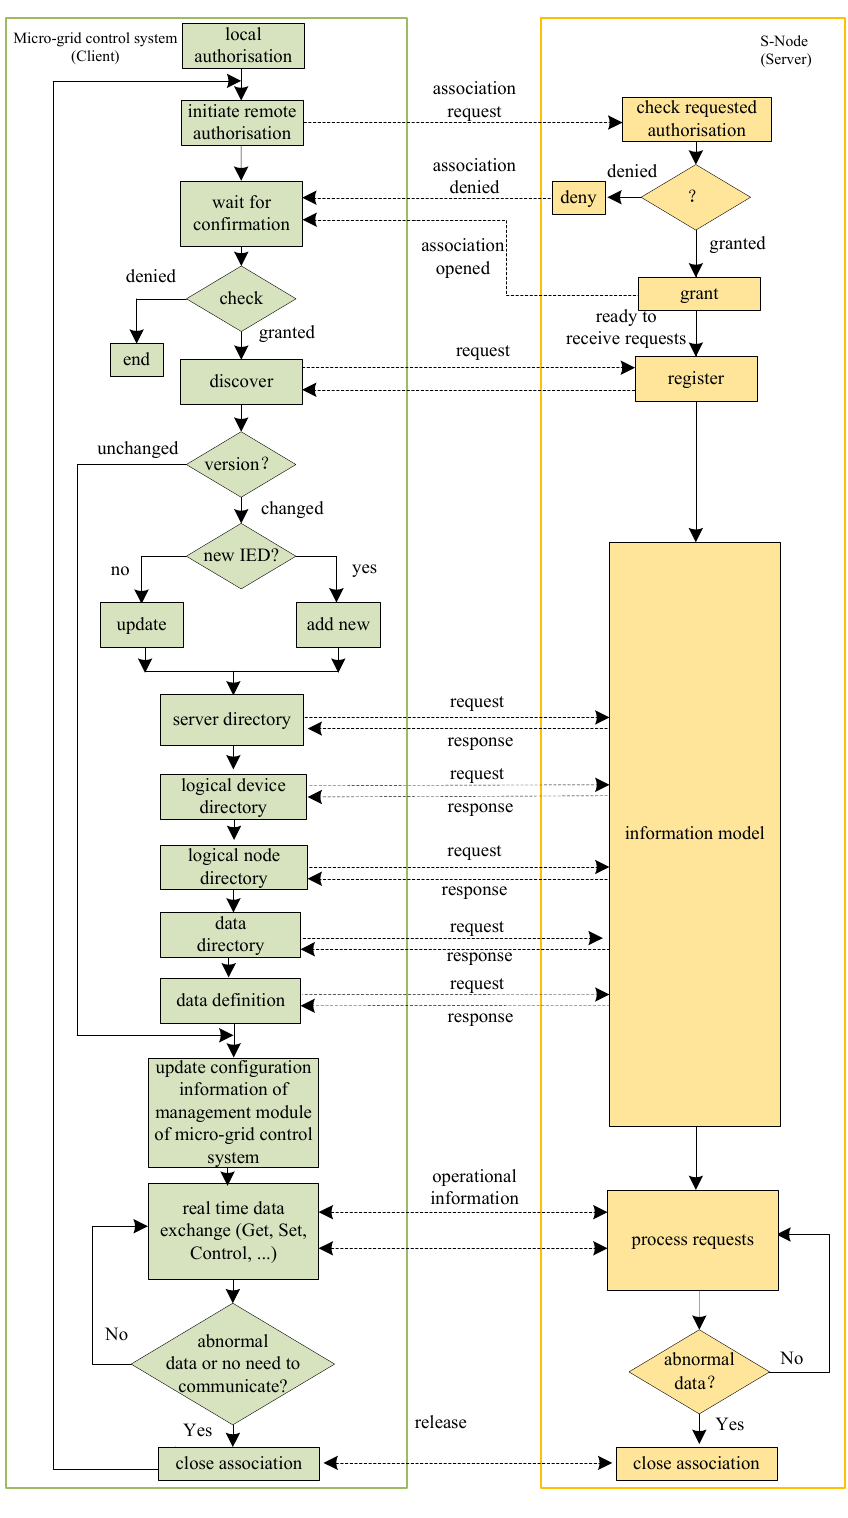
Figure 4. Procedures of “plug and play”